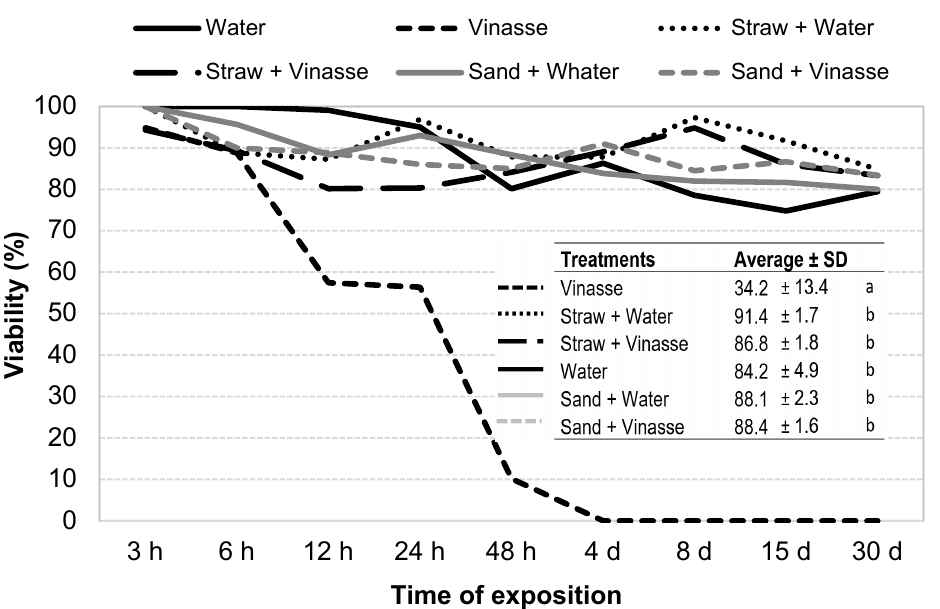
Figure 7. Viability of infective juveniles of Steinernema rarum (Pam 25) exposed to liquid vinasse; straw + vinasse; soil + vinasse; water; straw + water; and soil + water, during periods in hours (h) and days (d). The table shows means for viability over the entire experimental period (repeated measures) (n ± standard error). Means followed by different letters within columns differ significantly based on Tukey’s test ( p < 0.005).